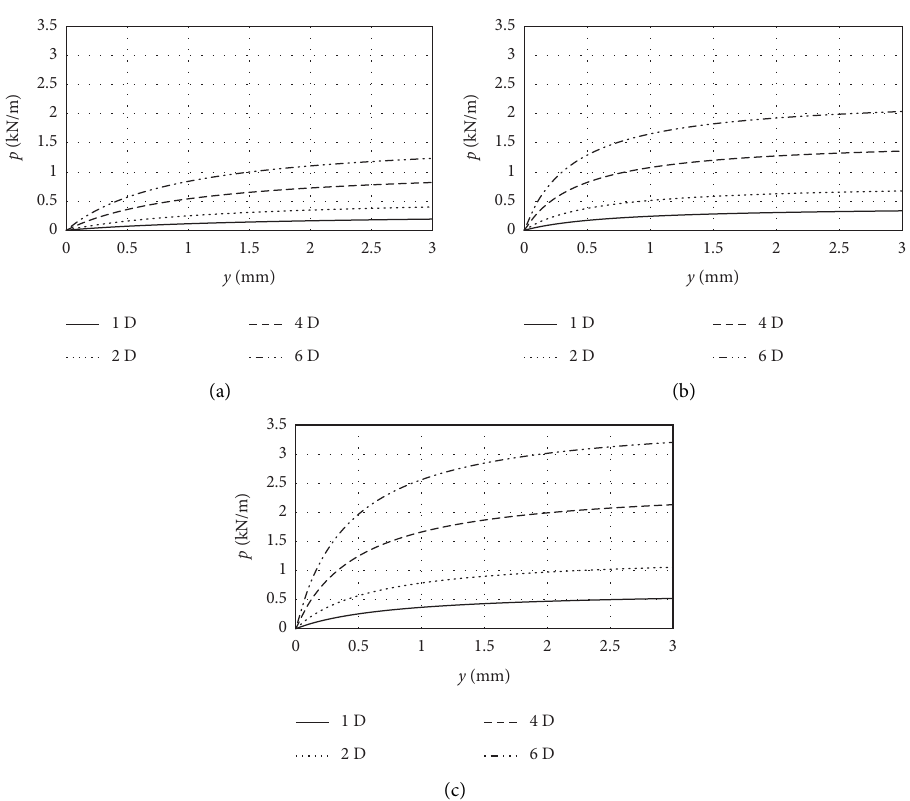
Figure 4: Experimental static p-y curves at depths of 1 D , 2 D , 4 D , and 6 D . (a) 40%. (b) 70%. (c)